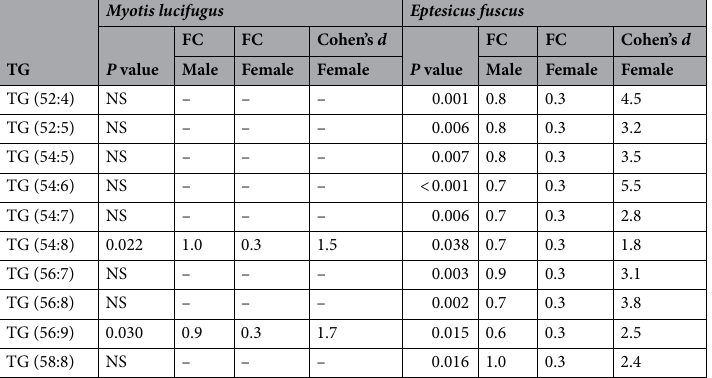
Table 1. Hepatic TG significantly altered in the white-nose syndrome (WNS)-susceptible Myotis lucifugus and less susceptible Eptesicus fuscus (sexes separate) after laboratory infection with the causal agent for WNS, Pseudogymnoascus destructans (Pd). FC = fold change, NS = nonsignificant, E. fuscus n = 4 for each sex and treatment, M. lucifugus n = 6 except Pd-inoculated ♀ n = 4.